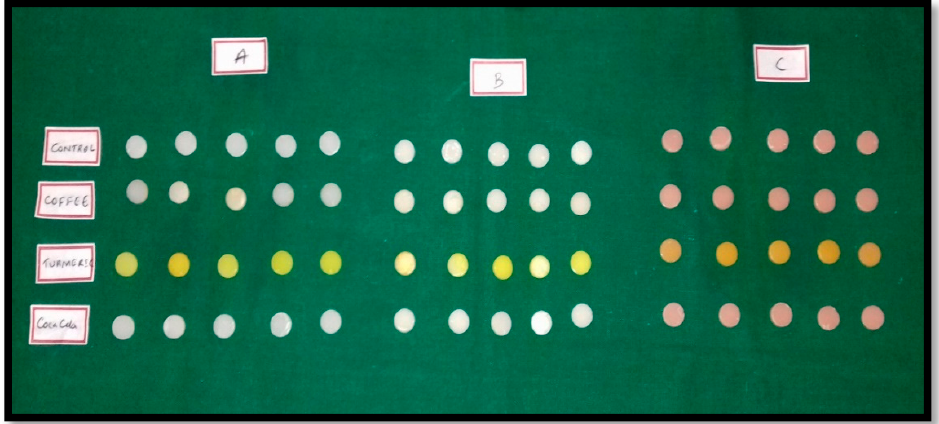
Figure 4. Specimens after 2 weeks of immersion in staining solution. ( A ) Incisal, ( B ) Dentin, ( C ) Gingiva